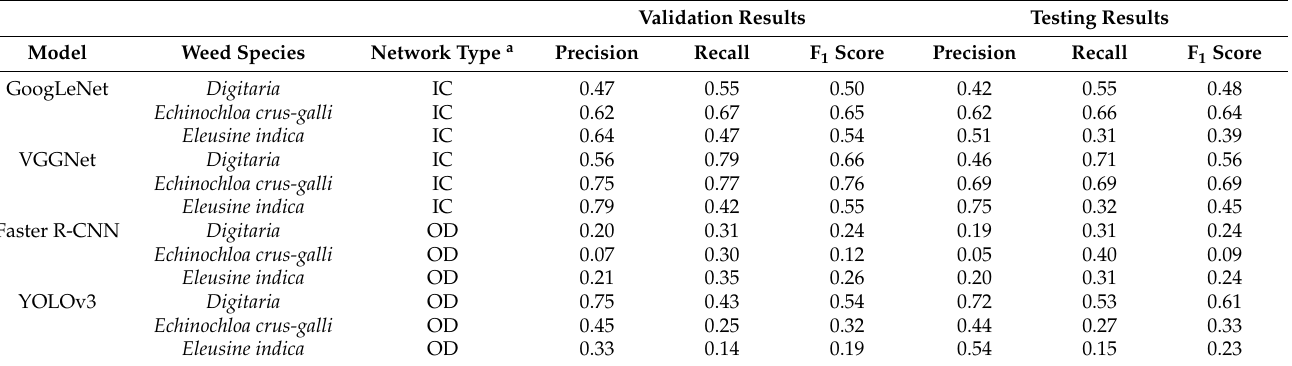
Table 5. Grass weed detection validation and testing results using various convolutional neural networks b